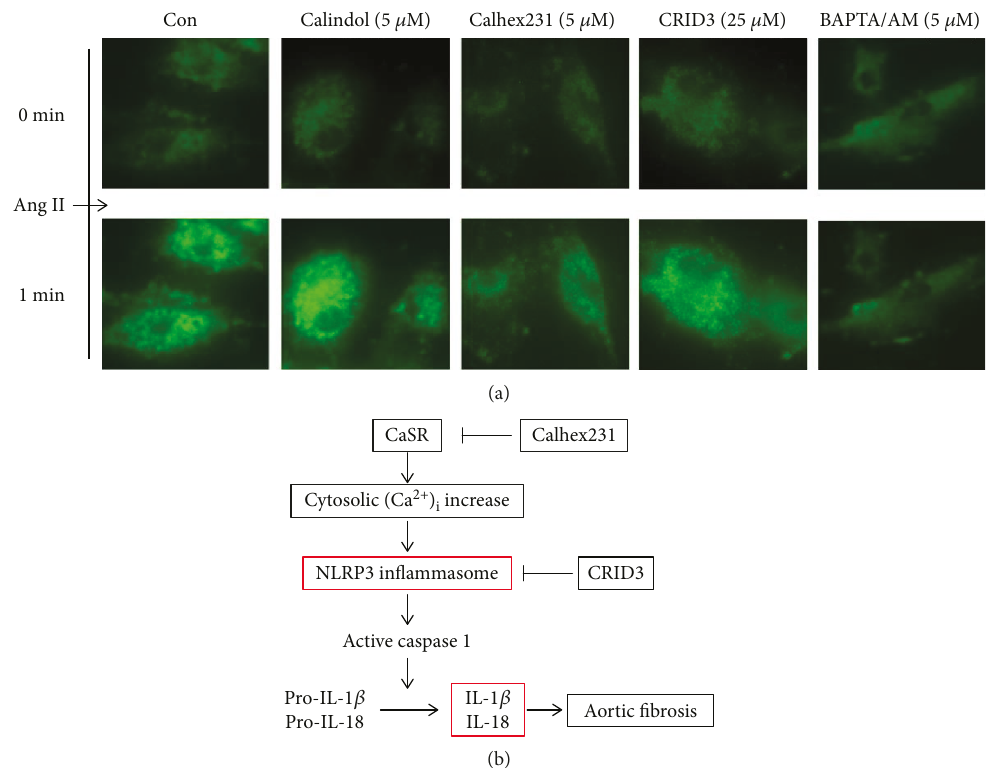
Figure 8: Calhex 231 pretreatment inhibits Ang II-induced increase in cytosolic [Ca 2+ ] in VSMCs. (a) The cytosolic [Ca 2+ ] was stained with i i fl uo3/AM and the levels of cytosolic [Ca 2+ ] were represented by intensity of fl uorescence. Ang II induced an increase in cytosolic [Ca 2+ ] i i, which was prevented when pretreatment of Calhex 231 and BAPTA/AM, n ≥ 10 . (b) The schematic diagram of the mechanism of CaSR and NLRP3 in fl ammasome in vascular remodeling during hypertension. In VSMCs, cytosolic [Ca 2+ ] increase induced by CaSR triggers i NLRP3 in fl ammasome activation; NLRP3 in fl ammasome induces cytokines IL-1 β and IL-18 release, which leads to aortic fi